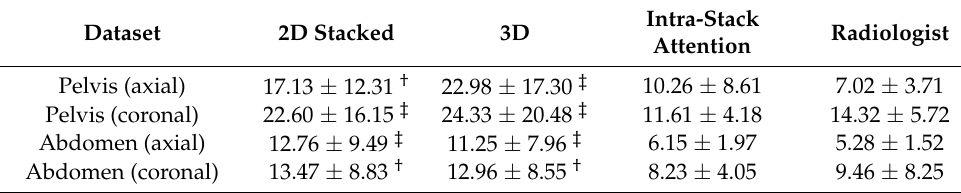
Table 2. Comparison of boundary position error averaged over four sides then over